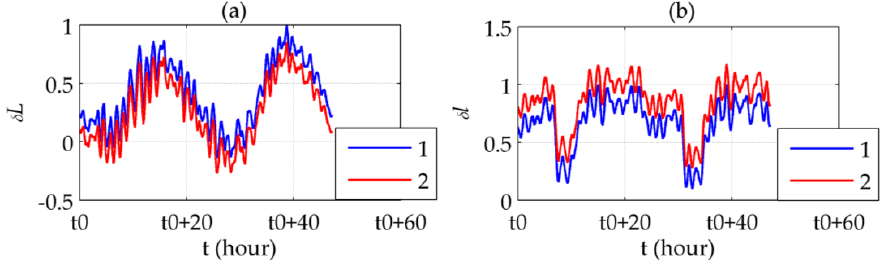
Figure 10. Results of the static experiment: ( a ) Latitude errors before (line 1) and after (line 2) compensation; ( b ) Longitude errors before (line 1) and after (line 2) compensation.